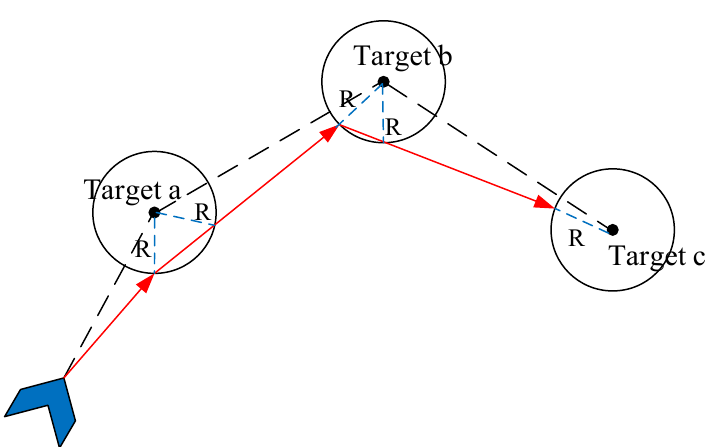
Figure 4. The optimal path of UAV carrying S ‐ 2 sensor.